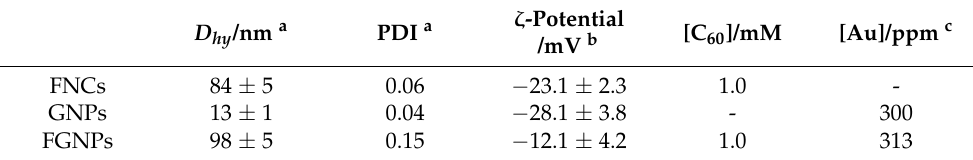
Table 1. Solution properties of FNCs, GNPs, and